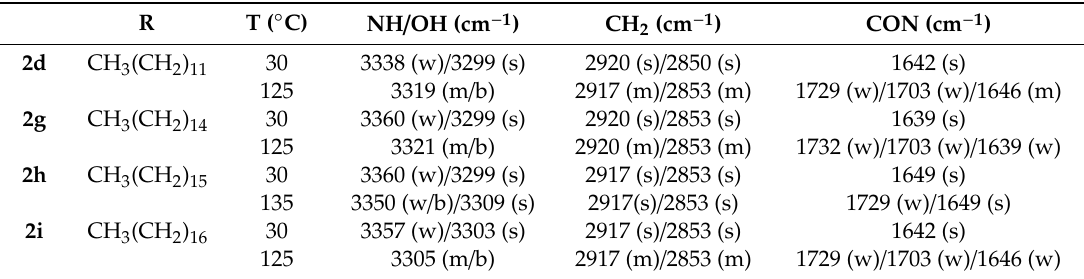
Table 4. E ff ect of temperature in the FTIR signals of characteristics bond vibration in some of the monoamides